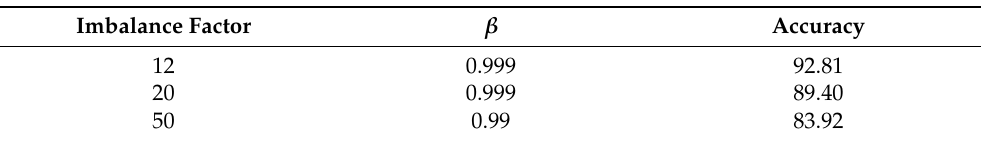
Figure 15. The number of samples in each category of the training set with imbalance factors of 12, 20 and 50. The blue line represents a factor of 12, the orange line represents a factor of 20, and the gray line represents a factor of 50. Table 6. Comparative experiments under different imbalance factors. The value of β in the second column is the best value after